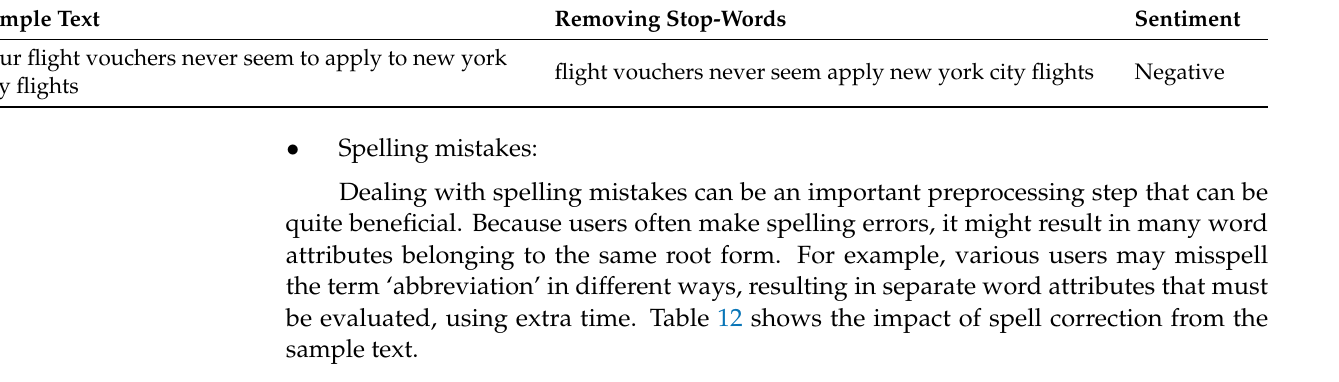
Table 12. Outcome after spelling mistake